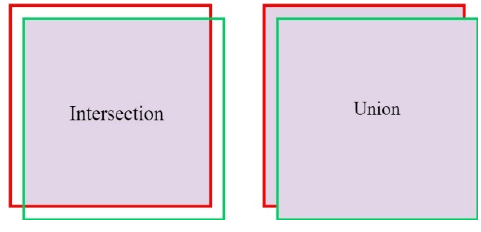
Figure 17. The schematic diagram of IoU.